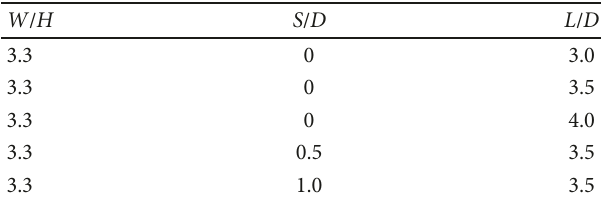
Figure 5: Photo of double S-shaped nozzles. Table 1: Geometric parameters of experimental